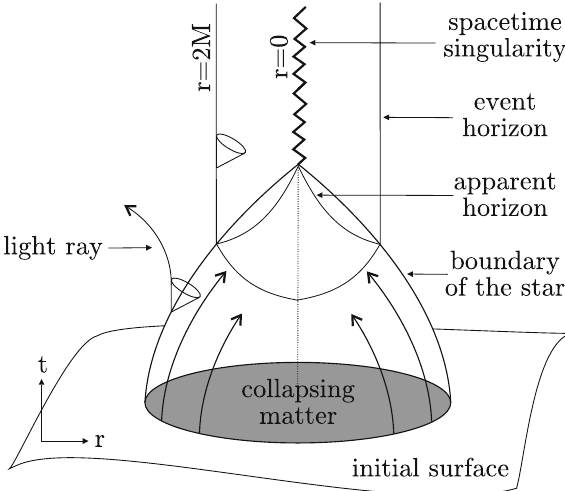
Fig. 2 Oppenheimer–Snyder–Datt (OSD) collapse: the figure shows dynamical evolution of a spherically symmetric, homoge- neous dust cloud collapse. Here, both the strong and weak cosmic censorship conjectures are valid. The picture is taken from